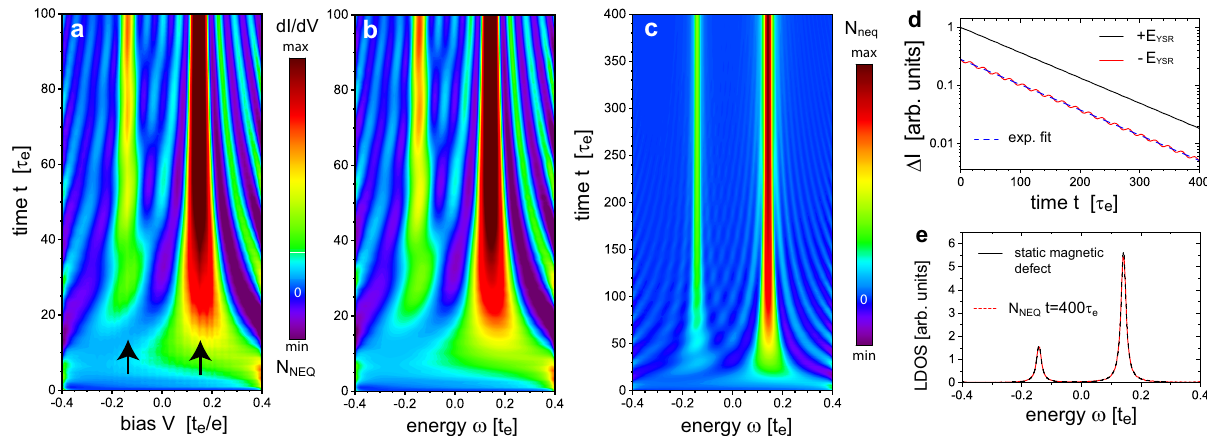
Fig. 1 Non-Equilibrium Emergence of Yu-Shiba-Rusinov States. Time evolution of a the differential conductance dI / dV , and b , c the non-equilibrium local density of states N neq ( r , t , ω ) at the site of the magnetic impurity (we set ℏ = 1 such that ω has the units of energy). The colorbar in a represents the normalized dI / dV , the colorbar next to c represents the normalized N neq in b , c . d Time evolution of the deviation of the Yu – Shiba – Rusinov (YSR) peaks' height from equilibrium, Δ I , as obtained from N neq in c . e Comparison of the equilibrium local density of states (LDOS) in the presence of a magnetic impurity, and N neq ( r , t , ω ) at t = 400 τ e . Here, τ e = ℏ / t e with the nearest-neighbor hopping parameter − t e . The calculation of dI / dV and N neq used identical parameters sets with ( μ , JS , Δ 0 ) = ( − 2.0, 1.8, 0.4) t e , and Γ = 0.01 t e . Here, μ is the chemical potential, J is the magnetic coupling, S is the spin of the adatoms and Δ 0 is the superconducting order parameter. For the calculation of dI / dV , we used t tun = 0.01 t e for the tunneling between the system and the tip, corresponding to the weak-tunneling limit. The same parameters are also used in the following fi gures. The results for N neq were obtained for a 50 × 50 site real space